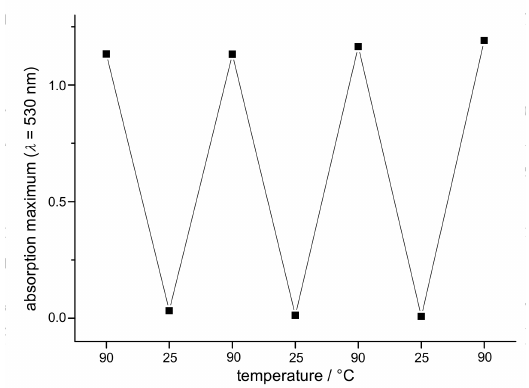
Figure 4. UV–vis measurement for temperature cycling on PE-AuNPs in toluene. The low value of absorption at 25 ◦ C indicates the absence of PE-AuNPs in the light pathway, which is located in the middle of cuvette. In this case, PE-AuNPs are segregated, as showed in Figure